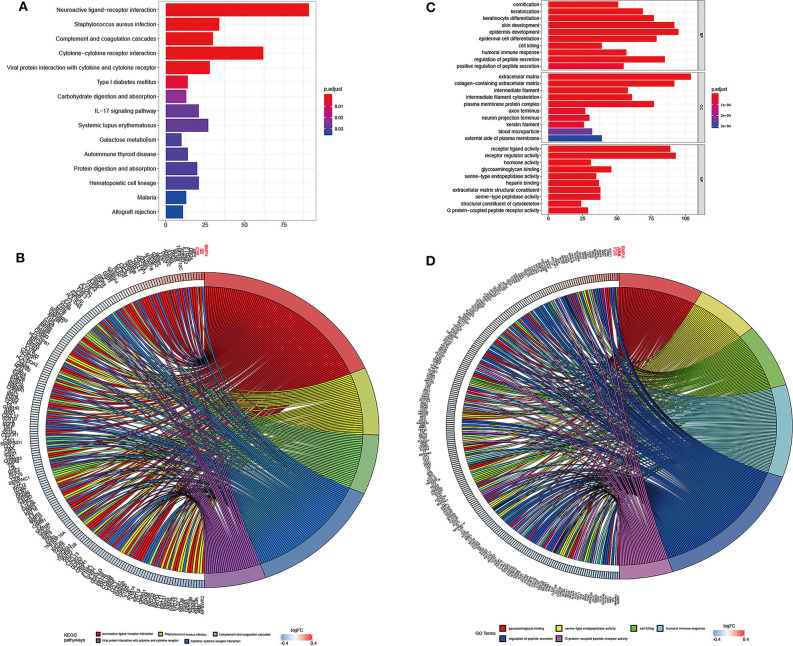
The top significantly enriched KEGG pathways and GO terms of associated genes for all the DMCs (n = 2,404) in HCC. The x axis shows the number of associated genes, and the y axis shows KEGG pathways (A) and GO terms (B). Color changes as the adjusted p value changes. Chord plot depicting the associated genes for all the DMGs (n = 2,404) with ribbons to their assigned KEGG pathways (C) and GO terms (D). Colored rectangles represent the log|FC| of genes.